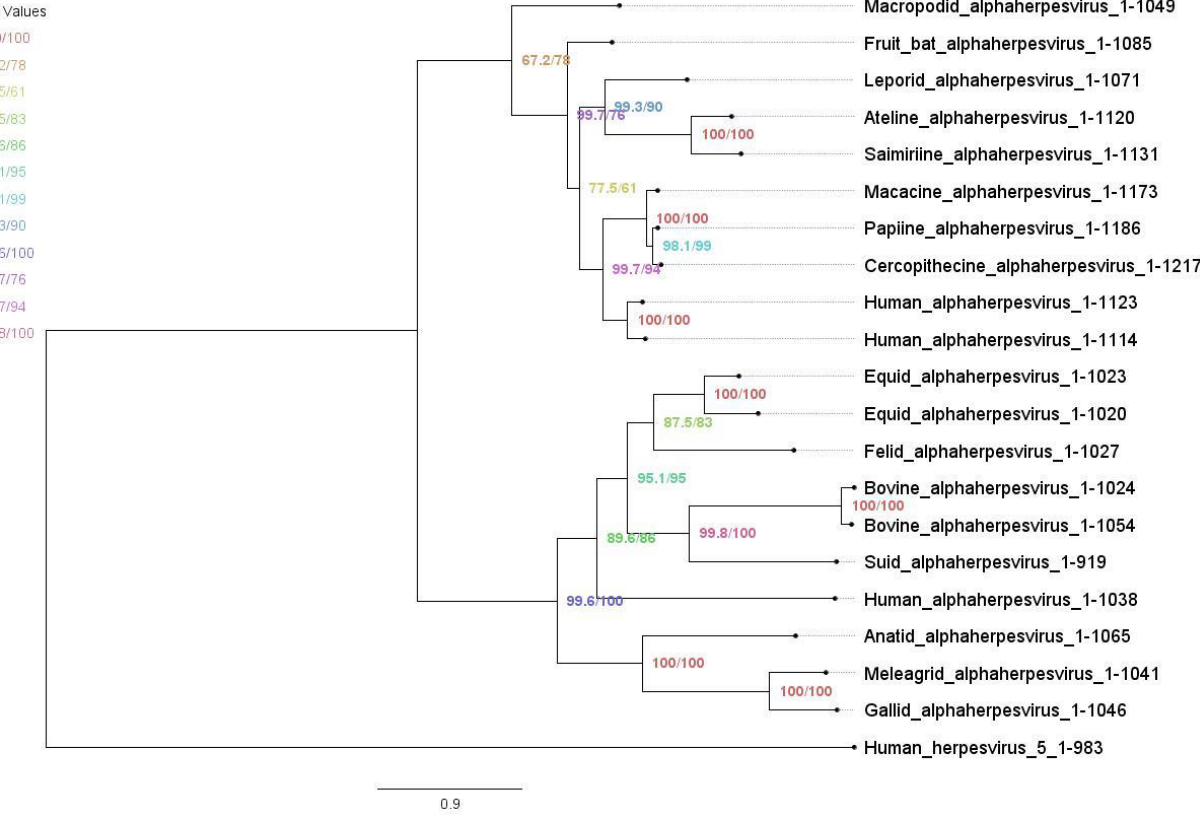
Figure 2. Phylogenetic tree of alphaherpesvirus UL37 orthologs under maximum likelihood. Maxi- mum likelihood tree with ultrafast bootstrapping using IQ-TREE Web Server. Bootstrap values are shown, ranging from 67.2 to 100.